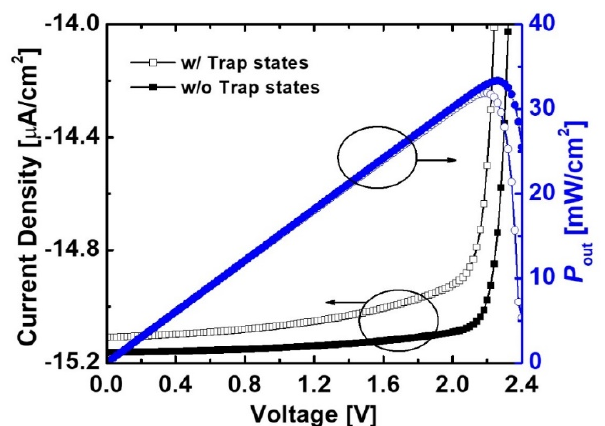
Figure 8. Current characteristics and P out of the e-beam-irradiated diodes without and with native trap states. The H p-GaN and H i-GaN in the diode were 100 nm and 700 nm, respectively. D p-GaN , D i-GaN , and D n-GaN were 5 × 10 17 cm −3 , 1 × 10 16 cm −3 , and 5 × 10 18 cm −3 , respectively.